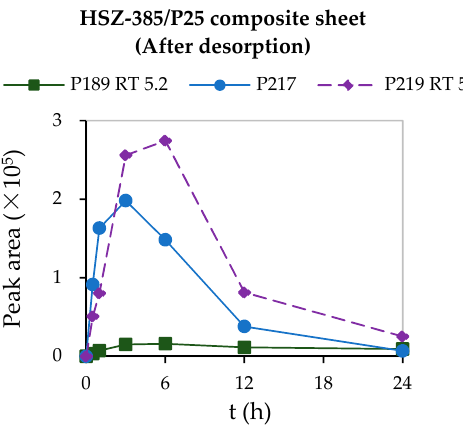
Figure 9. Changes in the areas of the peaks for the major intermediates over time in the HSZ-385/P25 composite sheet after desorption when crotamiton was photocatalytically degraded using the HSZ-385/P25 composite sheet ( C 0 = 10 mg/L). The squares are P189 (retention time 5.2 min), the circles are P217, and the diamonds with a dashed line are P219 (retention time 5.0 min).